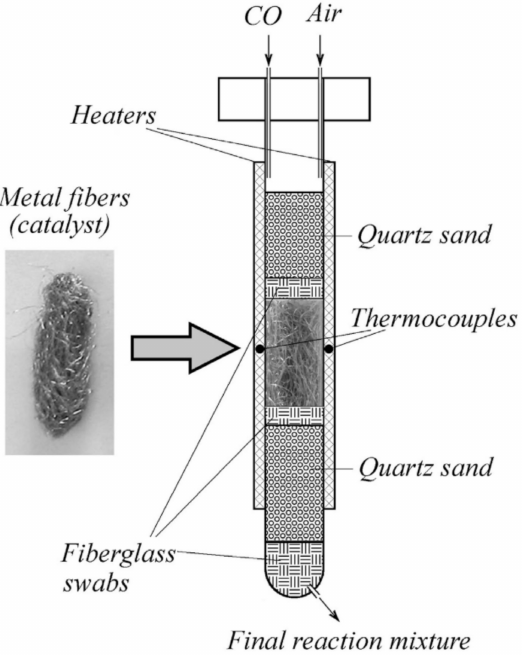
Figure 5. Scheme of the reactor loaded with metal fiber